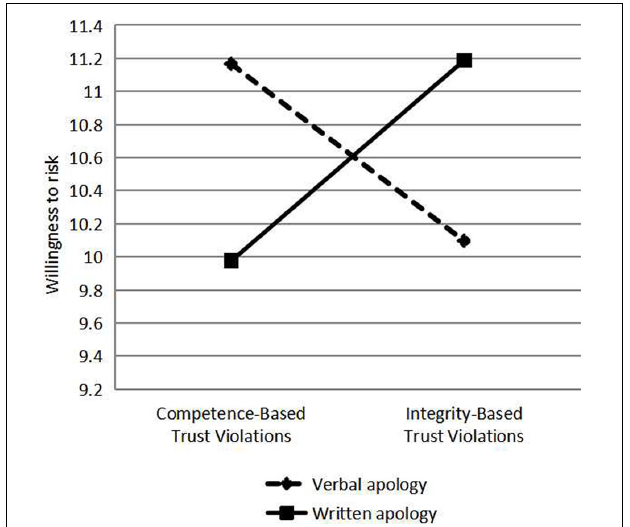
FIGURE 2 | Effects of violation type and response on perceived integrity.